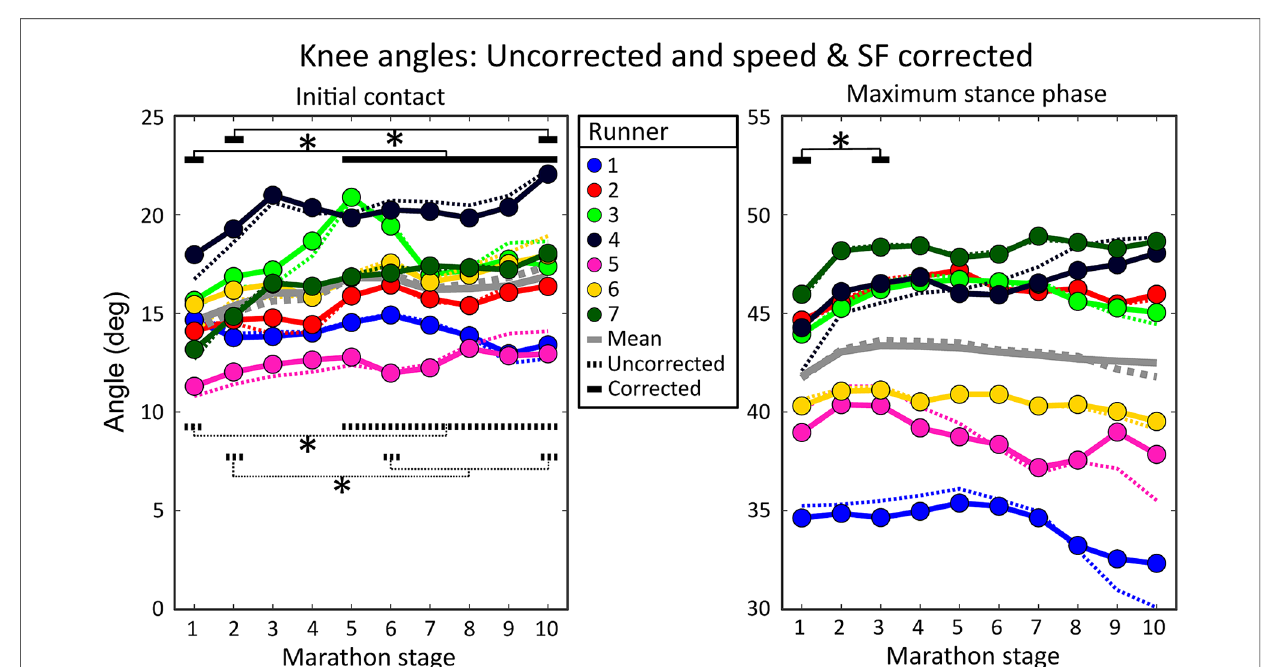
FIGURE 6 Individual mean knee angles during all marathon stages. The left fi gure shows knee angles at initial contact, while the right fi gure shows maximum stance phase knee fl exion angles. Dotted lines show uncorrected knee angles (i.e., as measured during the marathon). Solid lines represent speed and stride frequency corrected knee angles. Dotted black lines represent signi fi cant differences in uncorrected knee angles while solid black lines represent signi fi cant differences in knee angles corrected for the effect of changes in speed and stride frequency. Grey lines show the group means. Signi fi cant effects of marathon stage are shown with an asterisk and black